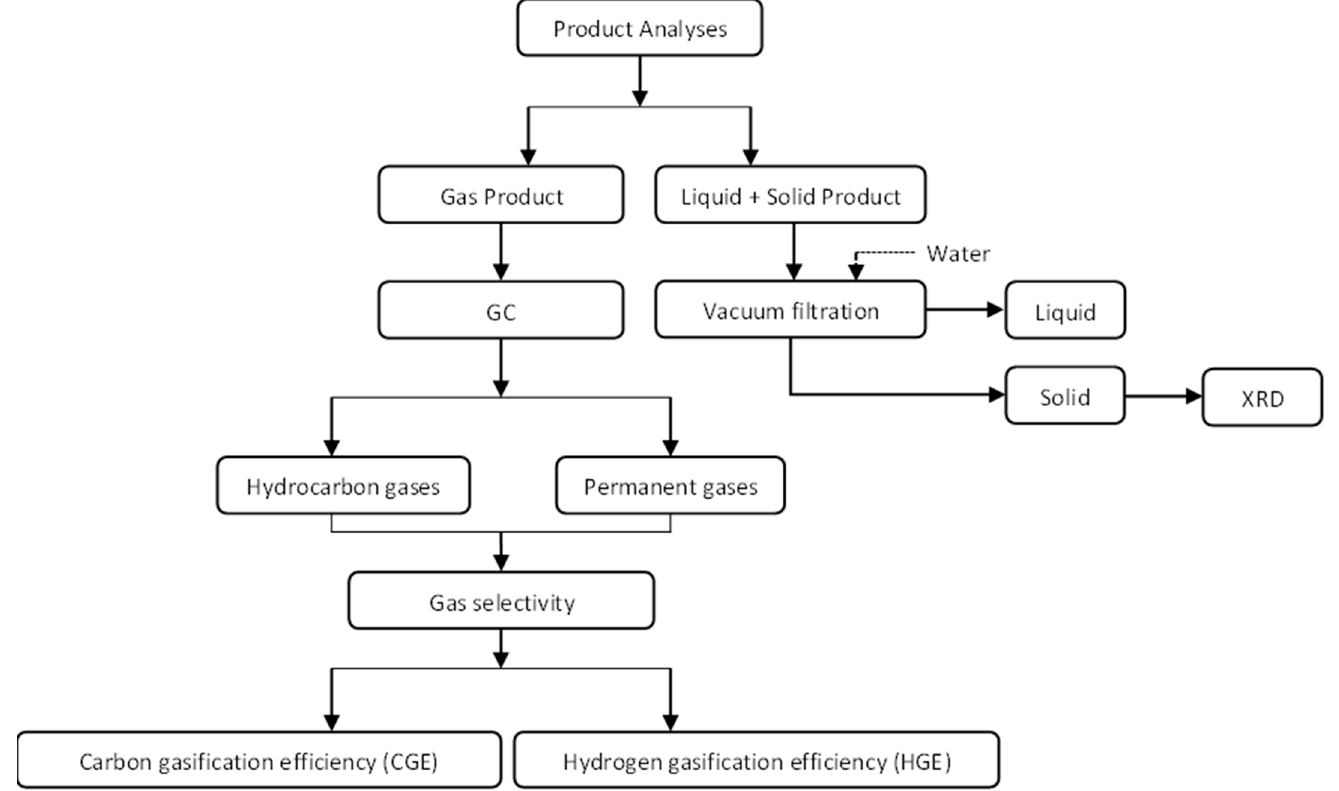
Figure 2. Schematic for product analyses.